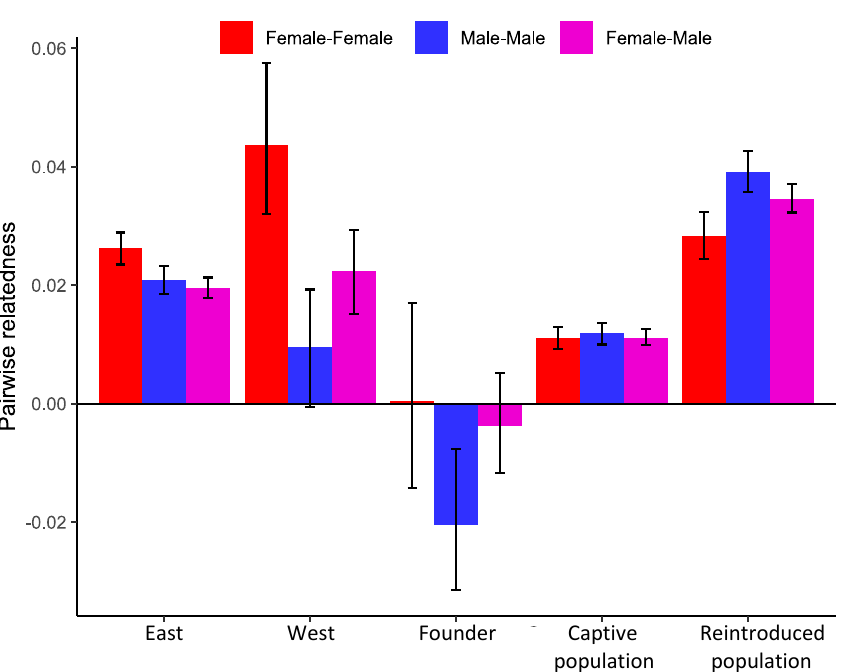
Figure 6. Mean pairwise genetic relatedness between female–female, male–male, and female–male Parantechinus apicalis pairs of the source populations (east and west), the wild-caught founders of the captive population, and the captive and reintroduced populations. Error bars are bootstrapped 95% confidence limits.